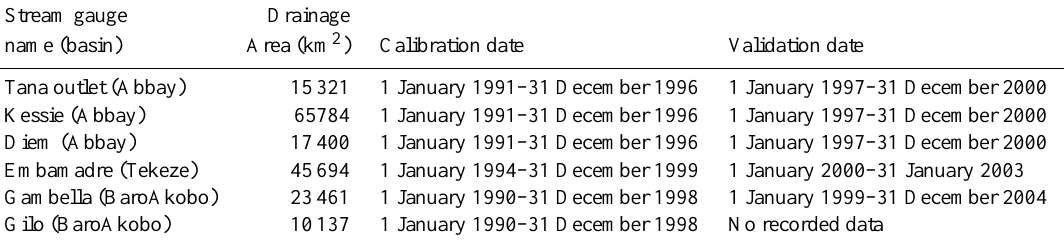
Table 3. Streams gauges and their corresponding drainage area with calibration and validation dates used for model simulations. Stream